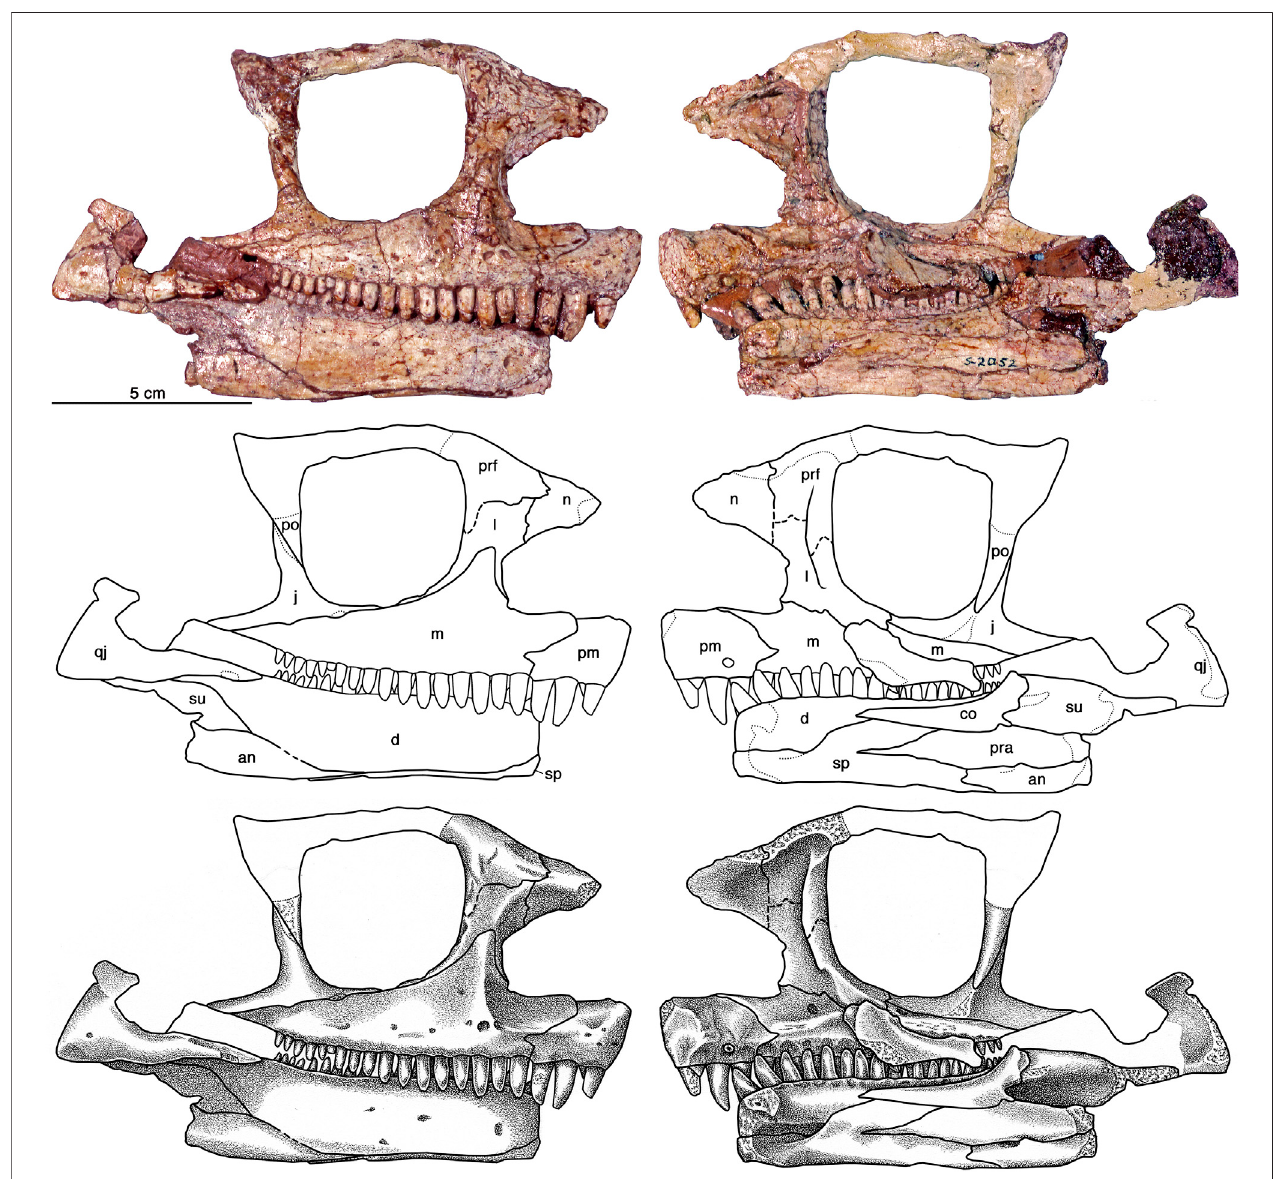
FIGURE 1 | Cotylorhynchus romeri , OMNH 00637, holotype. Right lateral and medial views of skull. Abbreviations: an, angular; co, coronoid; d, dentary; j, jugal; l, lacrimal; m, maxilla; n, nasal; pm, premaxilla; po, postorbital; pra, prearticular; prf, prefrontal; qj, quadratojugal; sp, splenial; su, surangular.